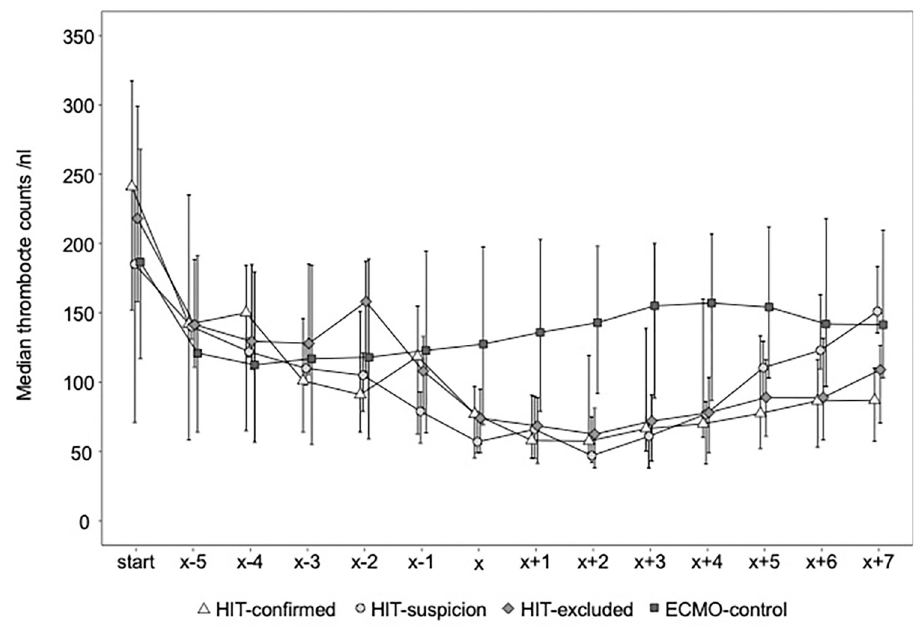
Fig 3. Platelet count on extracorporeal membrane oxygenation. Trajectories of thrombocytes before and after suspicion of heparin-induced thrombocytopenia (HIT) according to the groups: HIT-confirmed, HIT-suspicion, HIT- excluded and ECMO-control. Data show median and interquartile range (q1-q3). Time axis in days from day x. x: day of HIT suspicion (change to alternative anticoagulation) or, for group ECMO-control day 7 of ECMO therapy (as median time to HIT on ECMO was 7,5 days). 35 patients were excluded because the extracorporeal membrane oxygenation (ECMO) was explanted within 3 days after changing of anticoagulation or they died within 3 days after changing of anticoagulation, to show the effect of the alternative anticoagulation on coagulation parameters. Occasional missings e.g. if ECMO duration was shorter than 7 days.